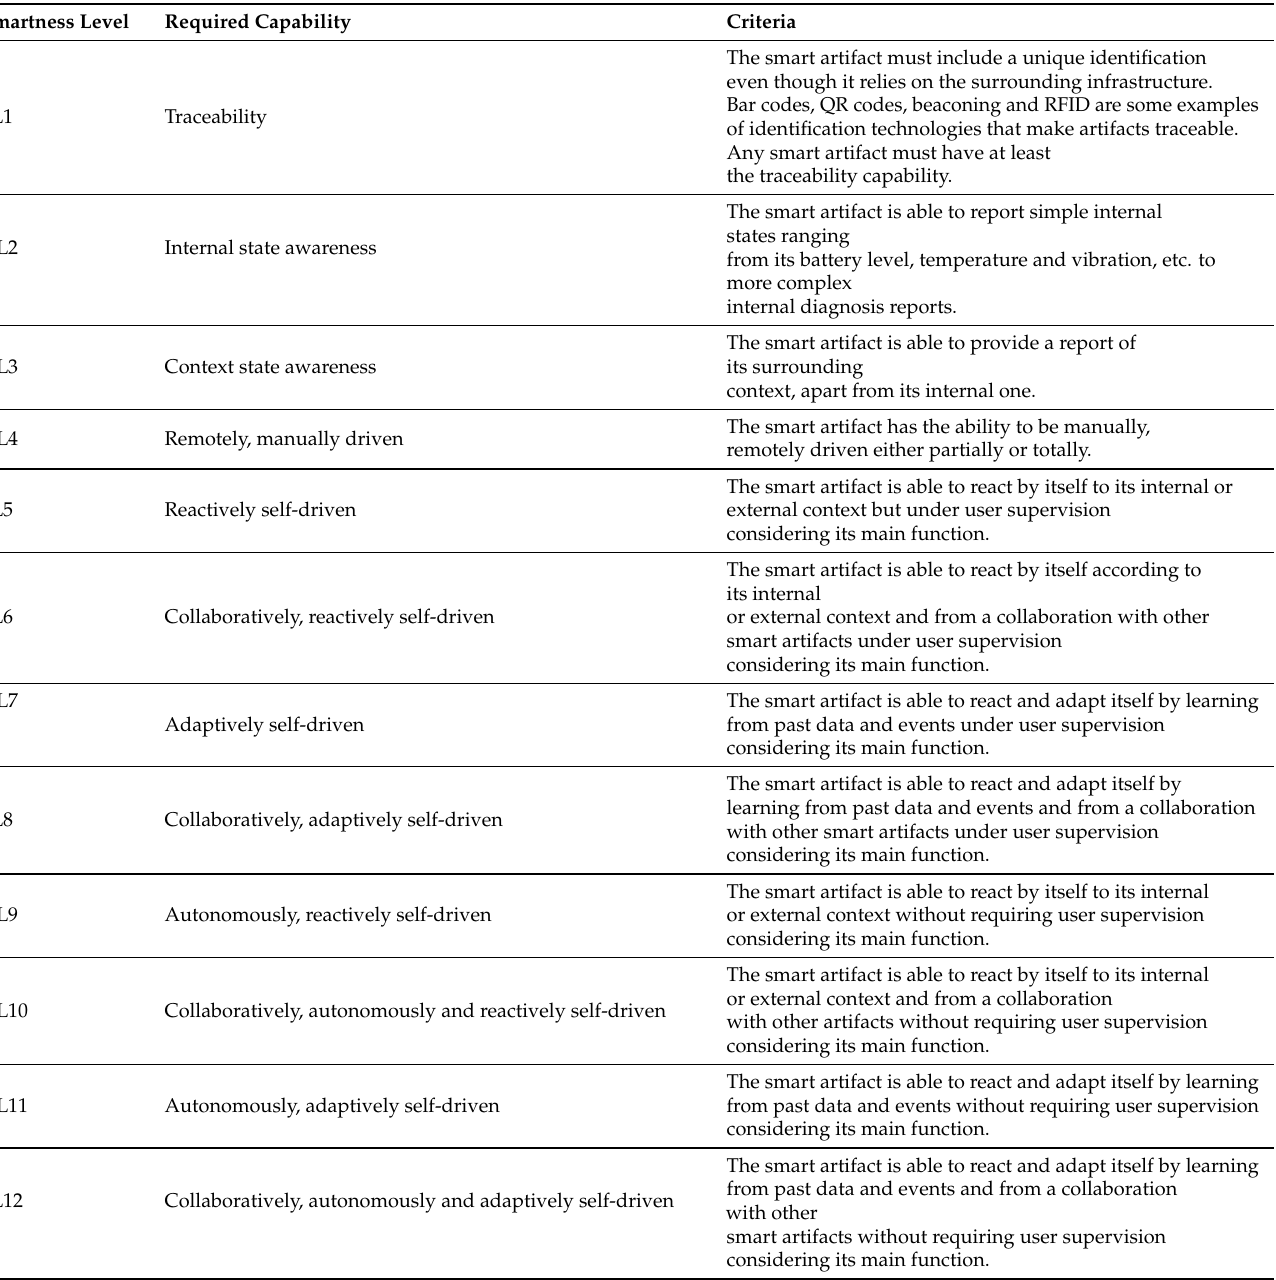
Table 2. Proposed uni-dimensional typology for classifying smart artifacts’ smartness